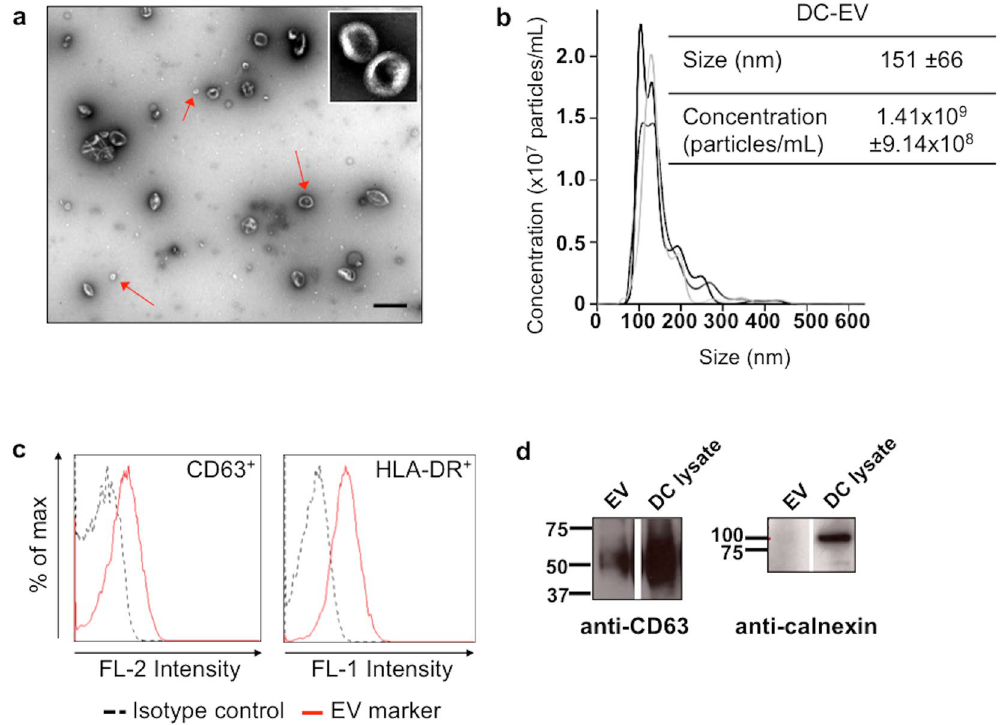
Figure 1. Characterization of exosome-enriched EV isolated from human monocyte-derived dendritic cells cultures. ( a ) Morphology of the isolated EV as imaged by transmission electron microscopy. Red arrows point to some EV of different sizes (scale bar: 500 nm). Image inset shows imaged EV in finer detail, at a magnification of 100,000x. ( b ) Characterization of concentration versus size distribution of isolated EV, by nanoparticle tracking analysis. Plot is representative of EV size and concentration analysis with NanoSight NS300. ( c ) Representative plots of conventional flow cytometry for the identification of the exosomal marker CD63 and the antigen- presenting cell marker HLA-DR on DC-derived EV, after immunostaining of DC-EV coupled to beads with CD63-PE and HLA-DR-FITC antibodies. ( d ) Representative western blots for the detection, as indicated, of the exosomal marker CD63 (non-reducing conditions) in isolated EV and DC whole lysates, and the endoplasmic reticulum marker calnexin (reducing conditions). Full gel scans are available in Supplementary Fig. S5. For all techniques n ≥